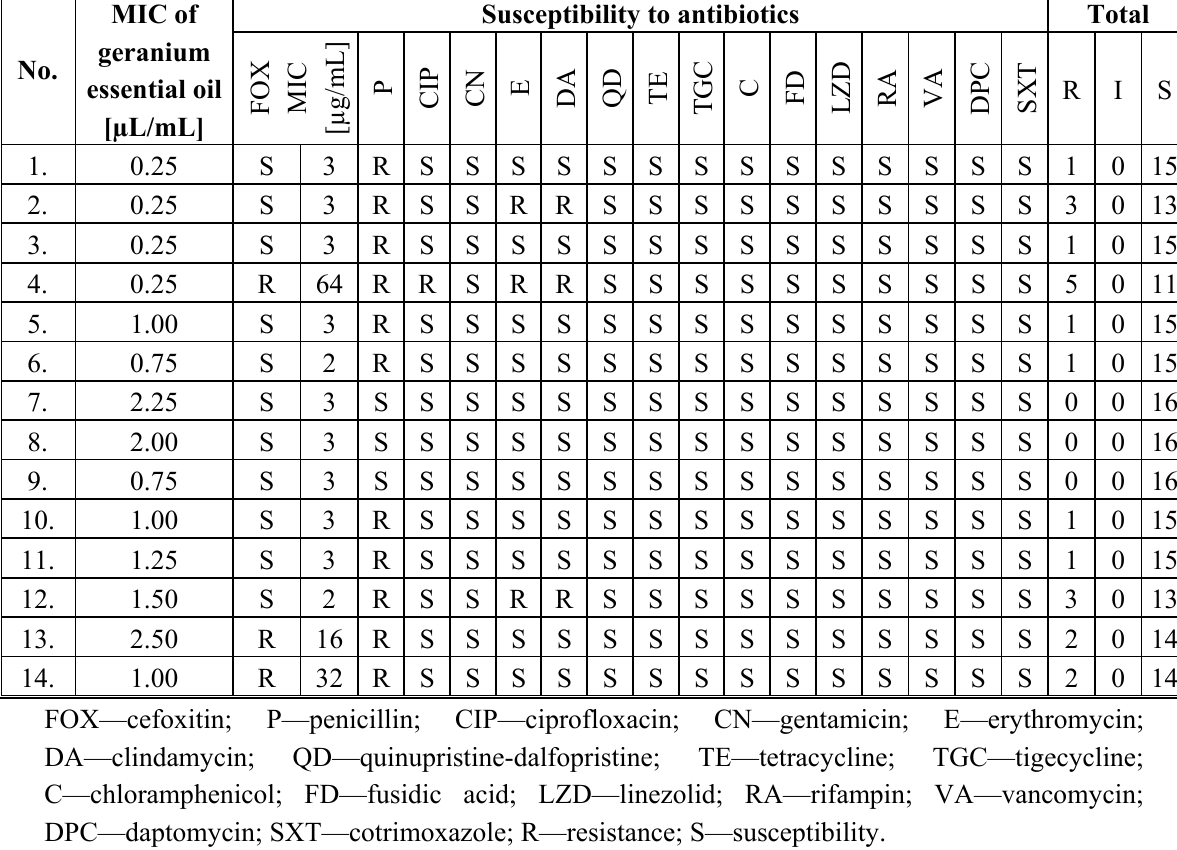
Table 8. Characteristics of S. aureus strains isolated from